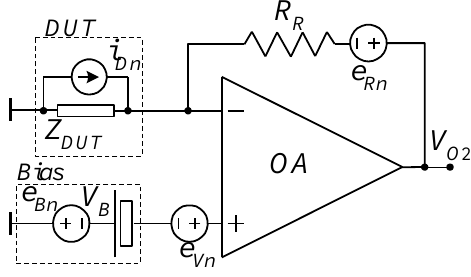
Figure 14. Alternative circuit for current noise measurements.